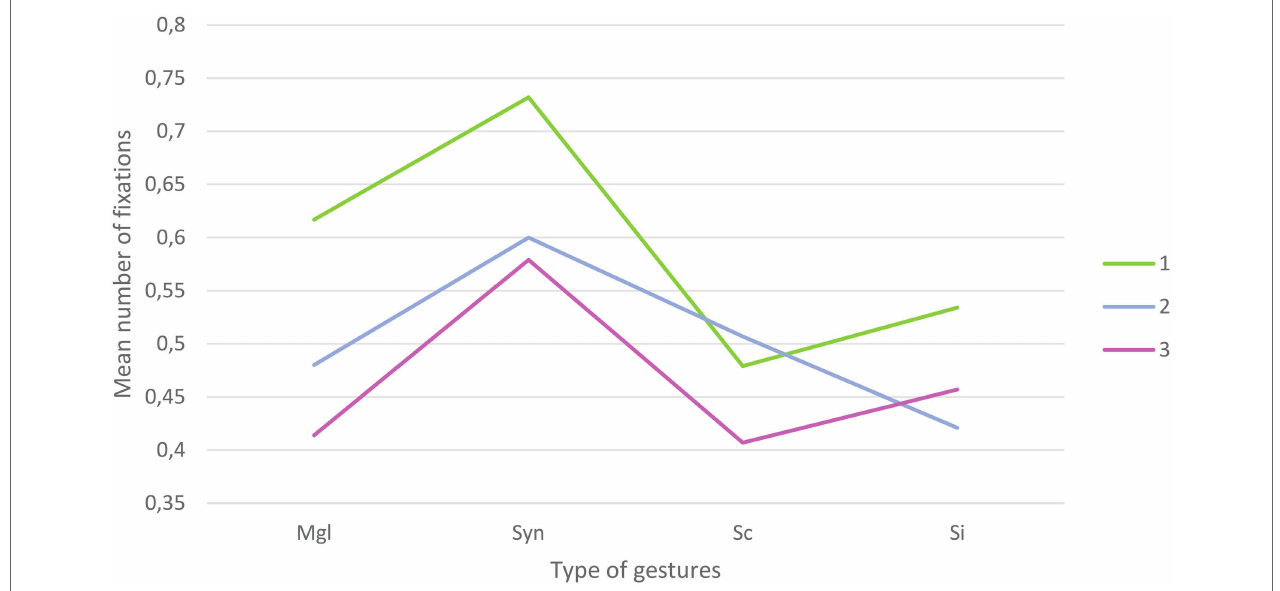
FIGURE 3 | Graphical representation of the interaction for number of fixations between the types of gestures presented and the level of hearing alteration (Mgl = Meaningless; Syn = syntactically incongruent; Sc = semantically congruent; SI = semantically incongruent; 1 = clear speech; 2 = 50% degradation; 3 = 100% degradation).